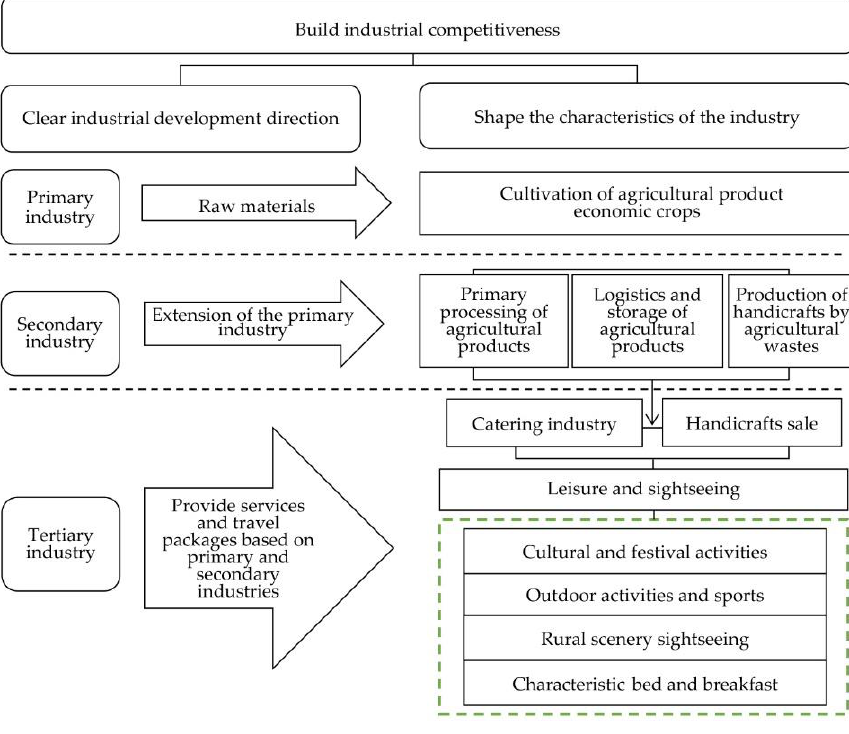
Figure 7. Schematic diagram of providing land for industrial development through agricultural land consolidation and construction land arrangement.